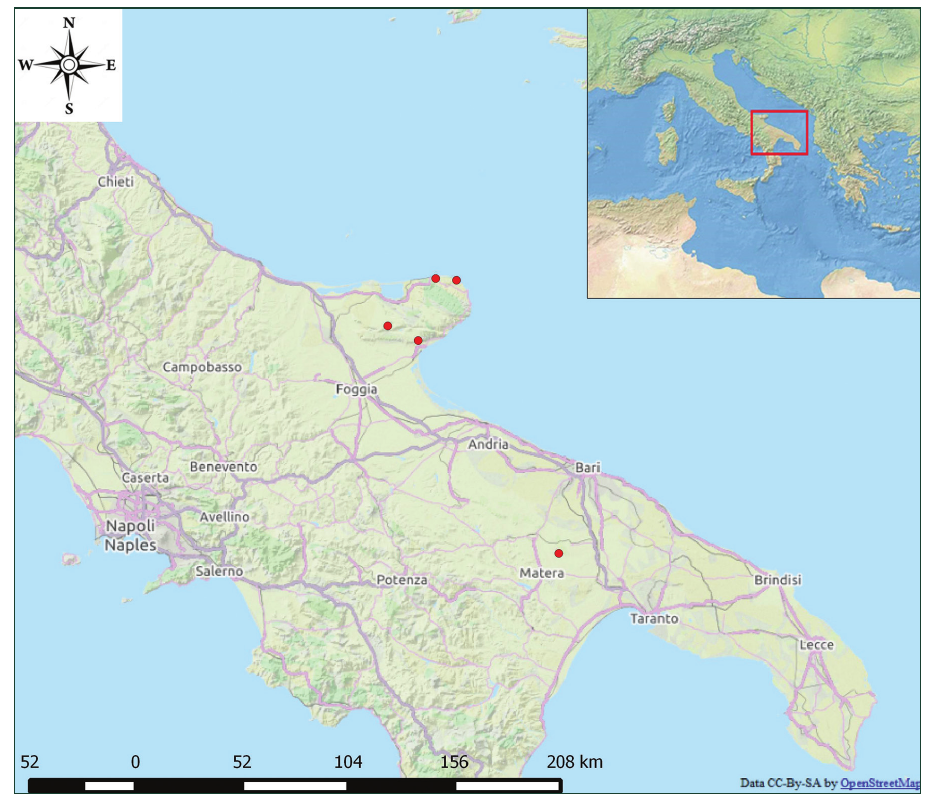
Figure 4. Geographic range and distribution map of Allium garganicum .